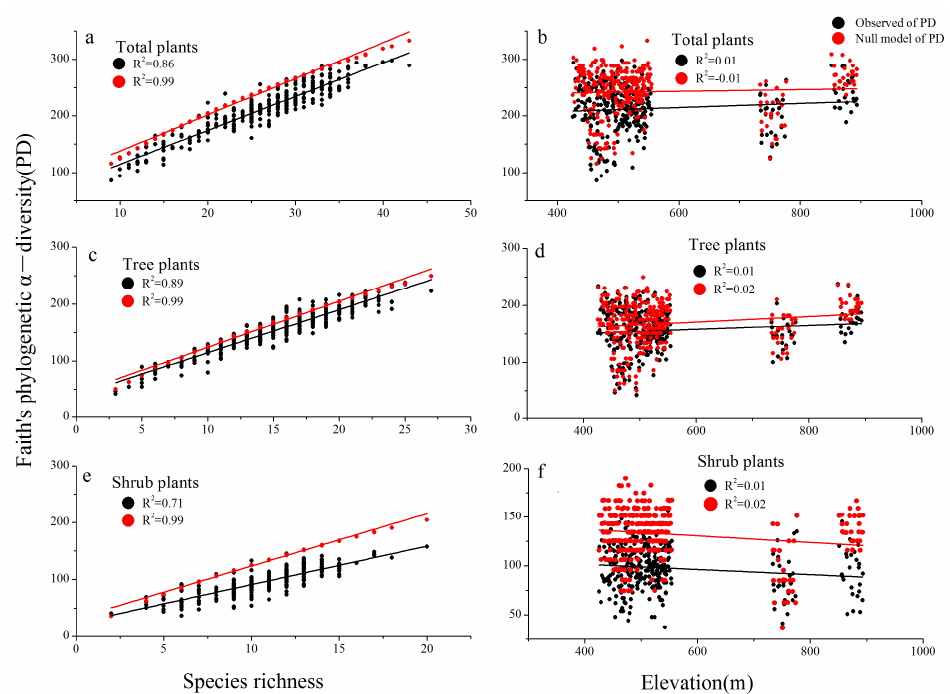
Figure 3. Relationships between phylogenetic α -diversity and species diversity and elevation. ( a ) Faith’s phylogenetic α -diversity (PD) and phylogenetic α -diversity based on the null model (S.E.S.PD) vs. species richness (SR) for totals; ( b ) PD and S.E.S.PD vs. elevation for totals; ( c ) PD and S.E.S.PD vs. SR for trees; ( d ) PD and S.E.S.PD vs. elevation for trees; ( e ) PD and S.E.S.PD vs. SR for shrubs; ( f ) PD and S.E.S.PD vs. elevation for shrubs.